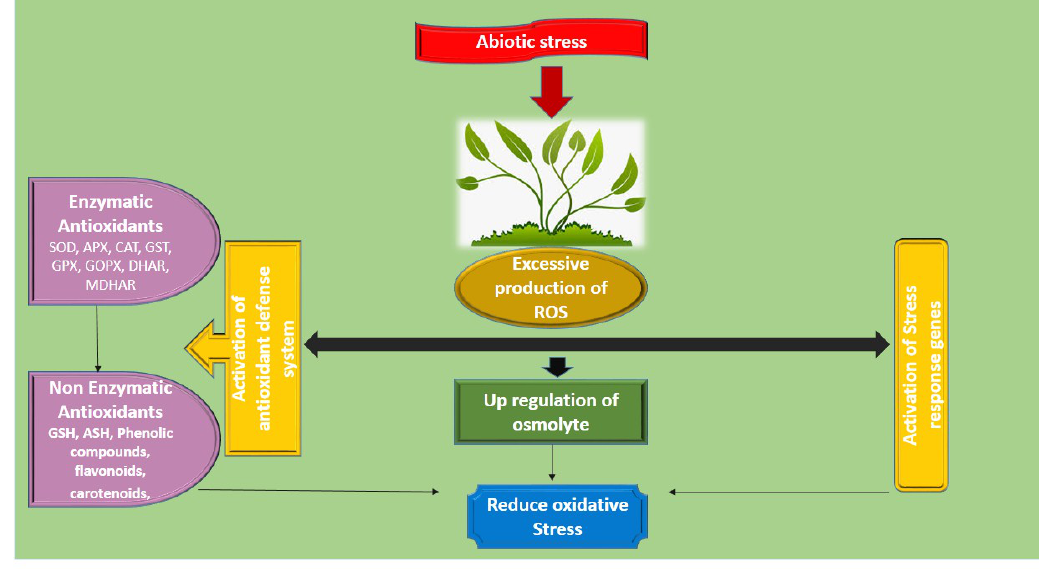
Figure 3. Abiotic stress response in plants.